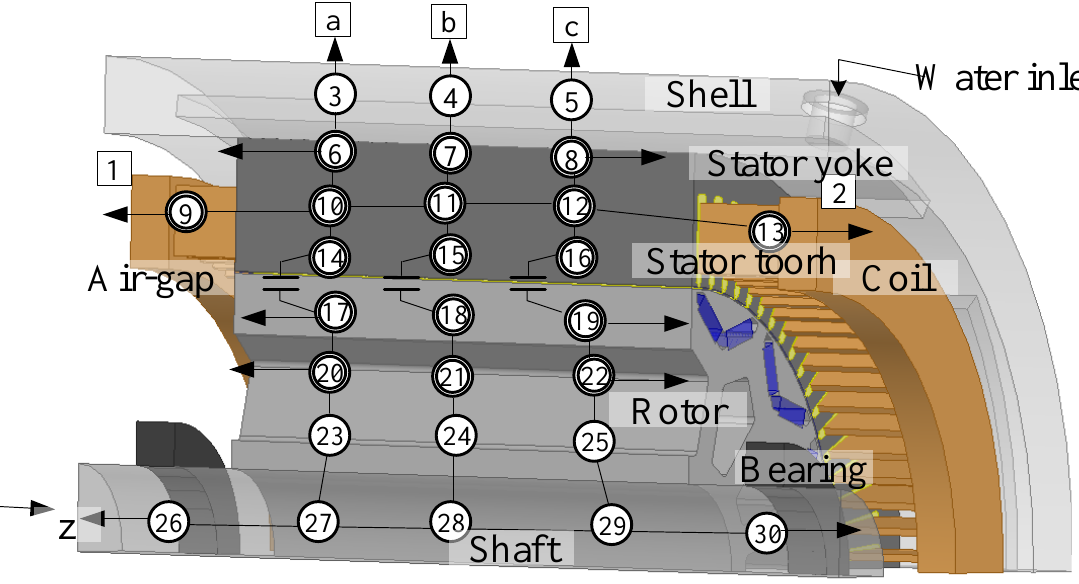
Figure 2. The LPTN model of a 200 kW PMSM.